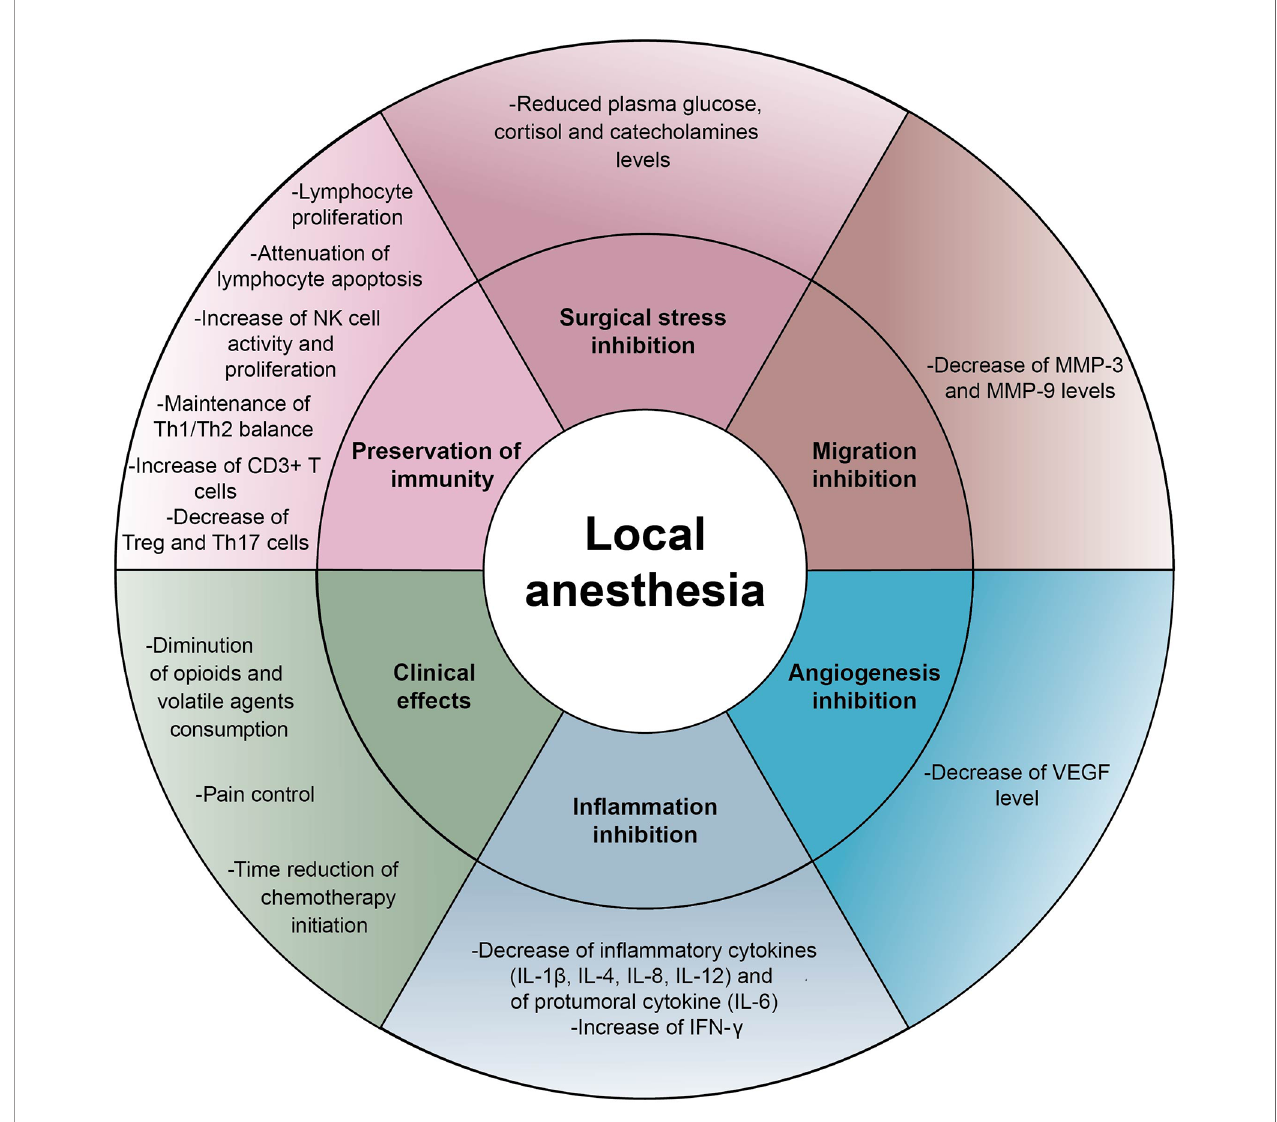
FIGURE 2 | Indirect effects of local anesthetics Schematic representation of indirect effects induced by local anesthetics on cancer cells and immune effectors: inhibition of in fl ammation, inhibition of cancer cell proliferation and migration, surgical stress control, reduction of neoangiogenesis, preservation of immunity and clinical effects. IFN, interferon; IL, interleukin; MMP, matrix metalloproteinase; NK, natural killer cell; VEGF, vascular endothelial growth